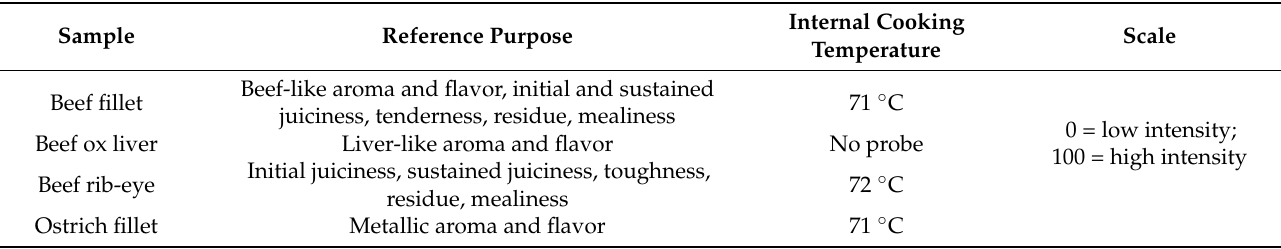
Table 2. Reference samples used during the training phase for the descriptive sensory analysis (DSA) of impala meat, by a panel of 11